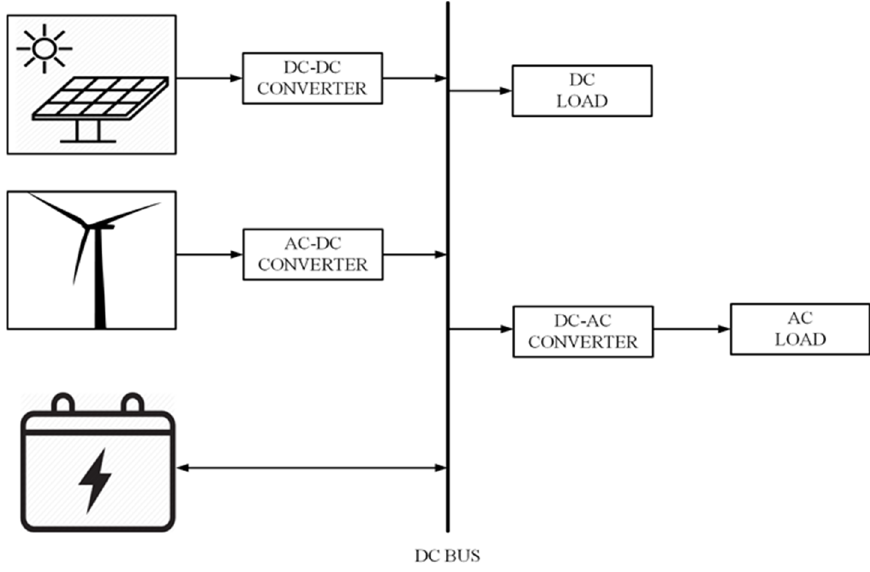
Figure 1. Renewable mix hybrid power generation system.